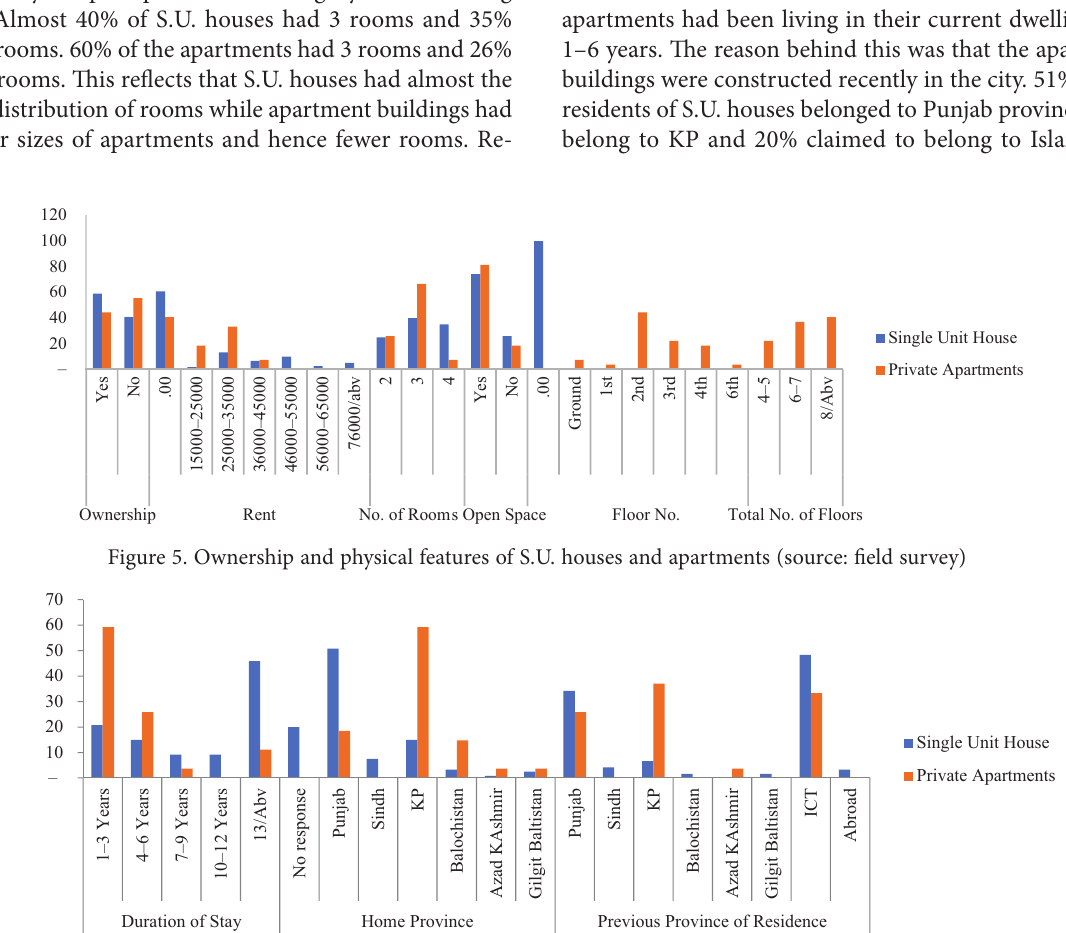
Figure 6. Occupation history of the residents of S.U. houses and apartments (source: field